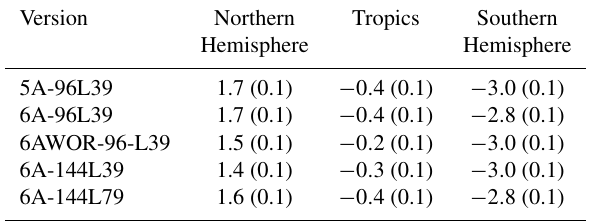
Table 2. Simulated mean gradients of CO 2 mixing ratios between MLO and other stations located in the Northern Hemisphere (lat- Southern Hemisphere (latitudes < 30 ◦ S). For each one of the three domains, the corresponding sites are weighted by the inverse of their standard deviation. The value inside the brackets defines the associ- ated mean weighted standard